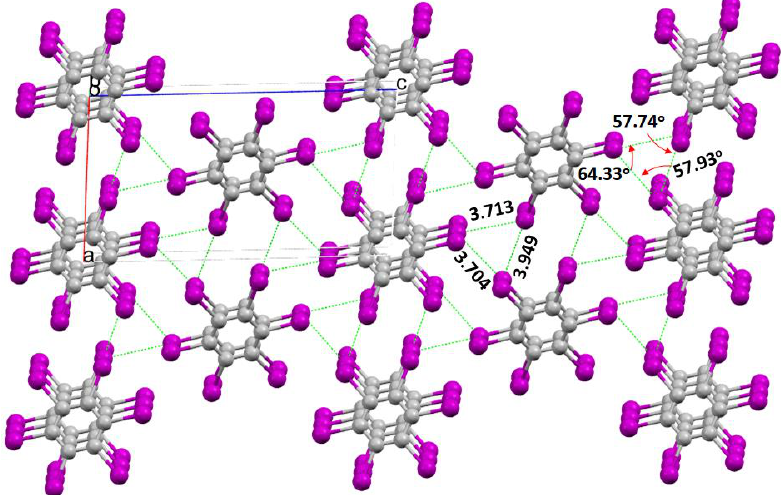
Figure 8. The triangular windmill-like X 3 topology in the structure of the crystal of hexaiodobenzene (C 6 I 6 ) (CSD ref: HIBENZ11 (2007)). The other two crystals of the same system displaying the same topology catalogued in CSD to have the reference codes HIBENZ01 (1970) and HIBENZ10 (1968). The ∠ X · · · X · · · X angle associated with the X 3 windmill is distorted from an ideal value of 60 ◦ , yet the three I atoms forming this are in the same plane. The intermolecular I · · · I distance accompanied with the X 3 windmill varies between 3.704 and 3.949 Å. The three ∠ I · · · I–C Type-II associated with the three halogen bonds that are linked with the triangular I 3 synthon are 173.59, 174.24, and 178.26 ◦ . The numerous Type-I interactions feasible in the crystal are not displayed. The C and I atoms are in grey and purple,